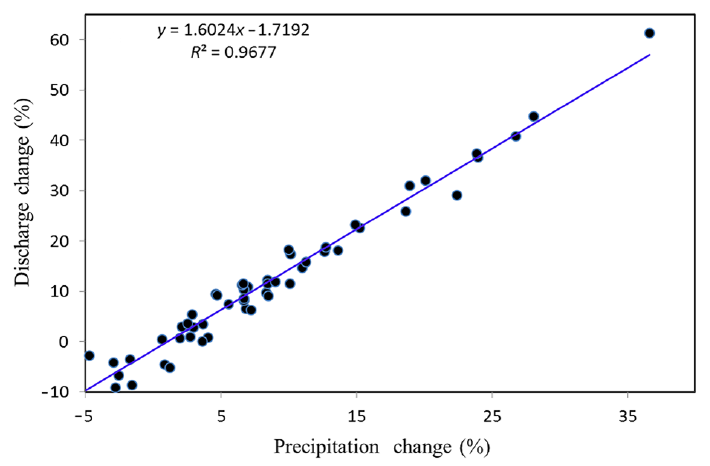
Figure 10. Relationship of projected changes in river flow to changes in annual precipitation in the Fujiang River basin (relative to 1971 – 2010). Fujiang River basin (relative to